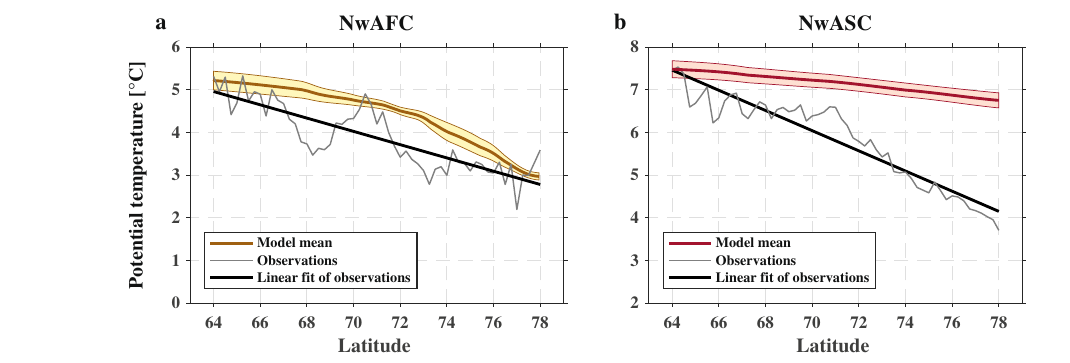
Fig. 4. The error bar indicates the standard error from the linear fi t.